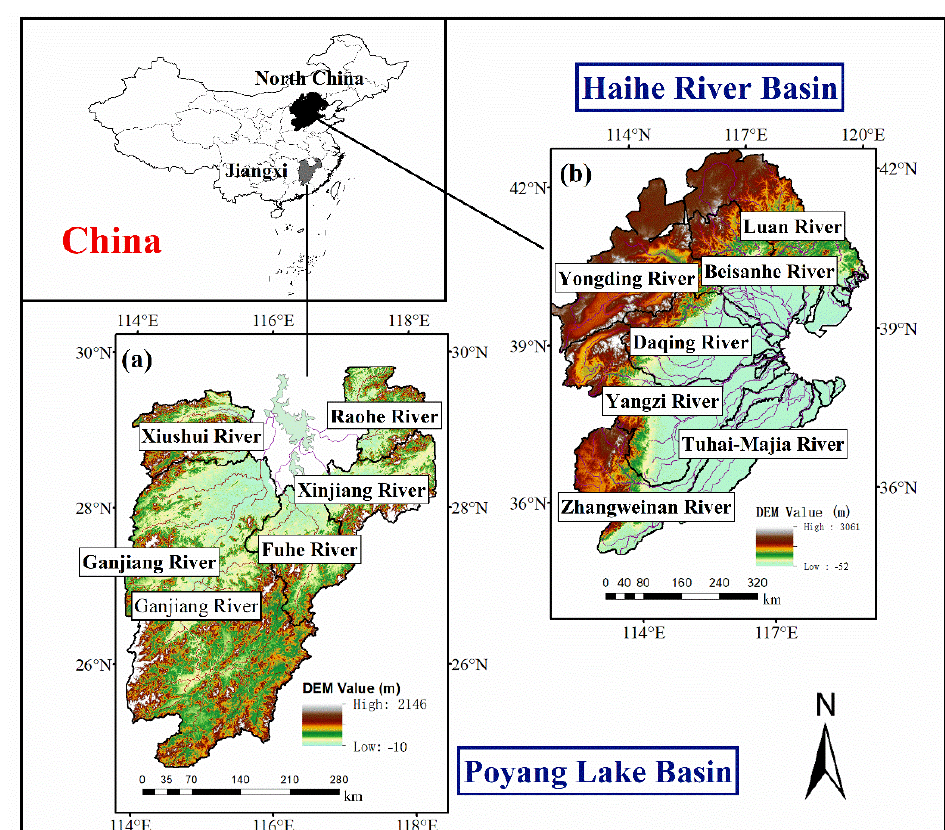
Figure 1. Location and Digital Elevation Model (DEM) of ( a ) PLB and ( b ) HRB. The annual average total amount of water resources in PLB was 163.06 billion m 3 , while the annual average total amount of water uses is 17.67 billion m 3 and the annual average quantity of wastewater is 4.39 billion m 3 . The total water resources of Ganjiang River, Fuhe River, Xinjiang River, Raohe River, and Xiushui River are 89.13, 20.19, 21.11, 15.77, and 16.86 billion m 3 , respectively. The average annual runoff in PLB into Poyang Lake is 142.73 billion m 3 . The annual average runoff totals of Ganjiang River, Fuhe River, Xinjiang River, Raohe River, and Xiushui River into Poyang Lake are 81.26, 16.20, 18.53, 14.04, and12.70 billion m 3 ,